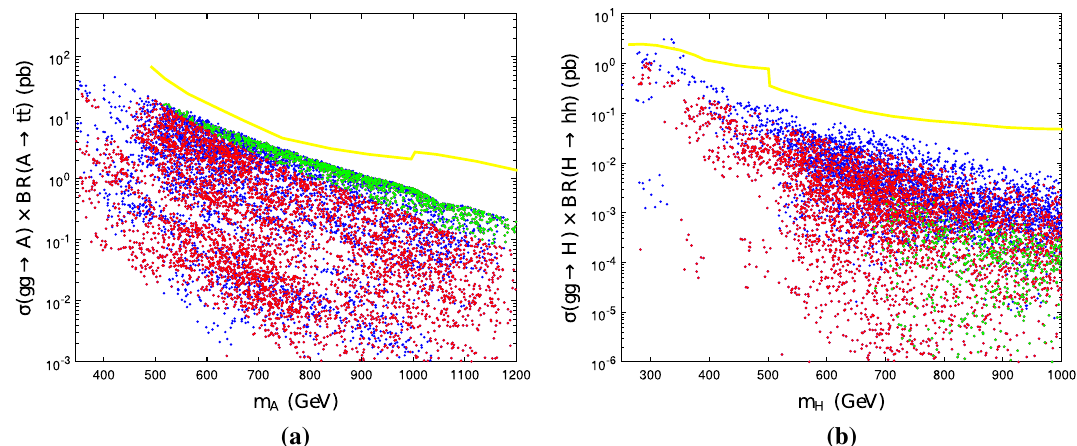
Fig. 5 a The gluon–gluon production and decay to t ¯ t of the pseu- doscalar A versus its mass. The yellow line is the upper 2 σ bound in figure 11 of Ref. [28]. b The gluon–gluon production and decay to hh of the scalar H versus its mass. All the points displayed obey the con- straints described in Sect. 4. For the blue points, h has production rates